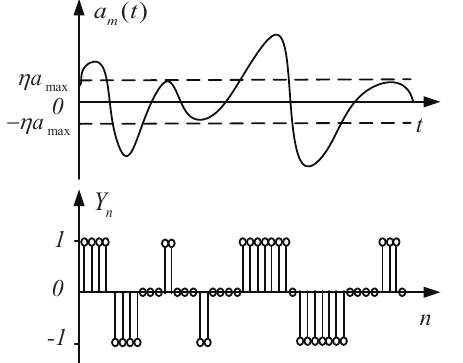
and the desired output m ( t )